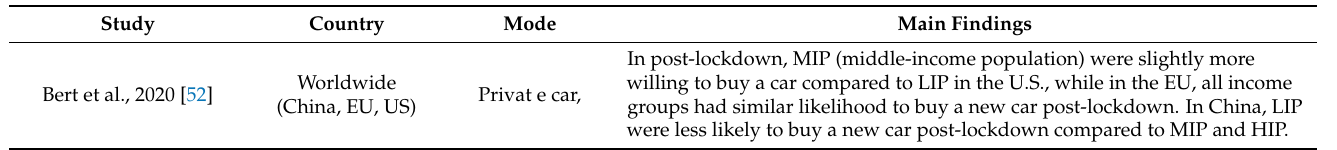
Table 4. Reviewed studies related to COVID-19 impacts on the mobility and activities of low-income